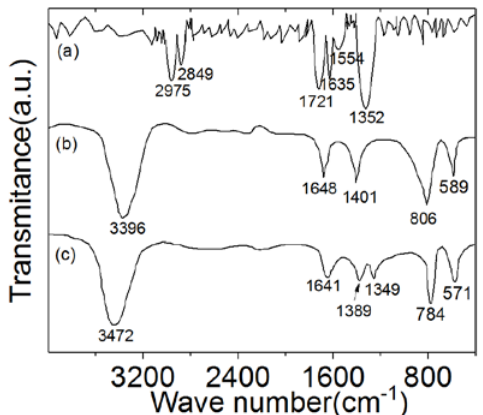
Figure 2. FTIR spectra of ( a ) hexazinone, ( b ) Co–Al LDHs, and ( c ) Co–Al LDHs after hexazinone adsorption.